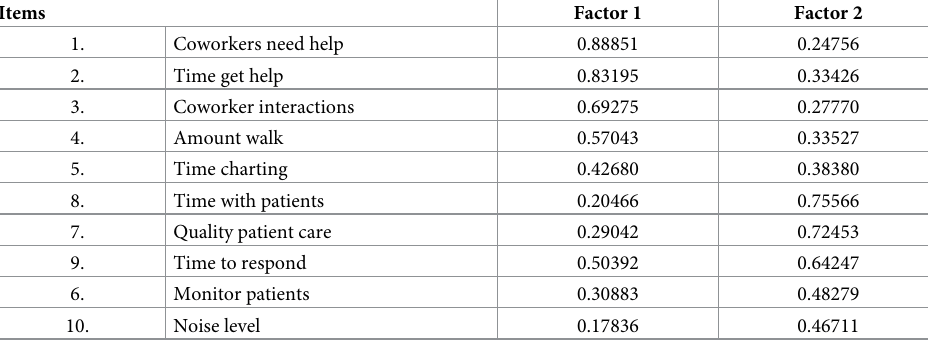
Table 6. Phase 1 varimax rotated two-factor model